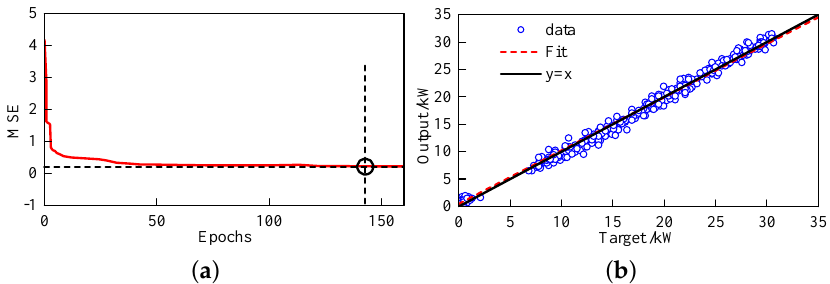
Figure 6. Neural network training performance and regression. ( a ) Mean squared errors vs. epochs; ( b ) the regression between training data and output.